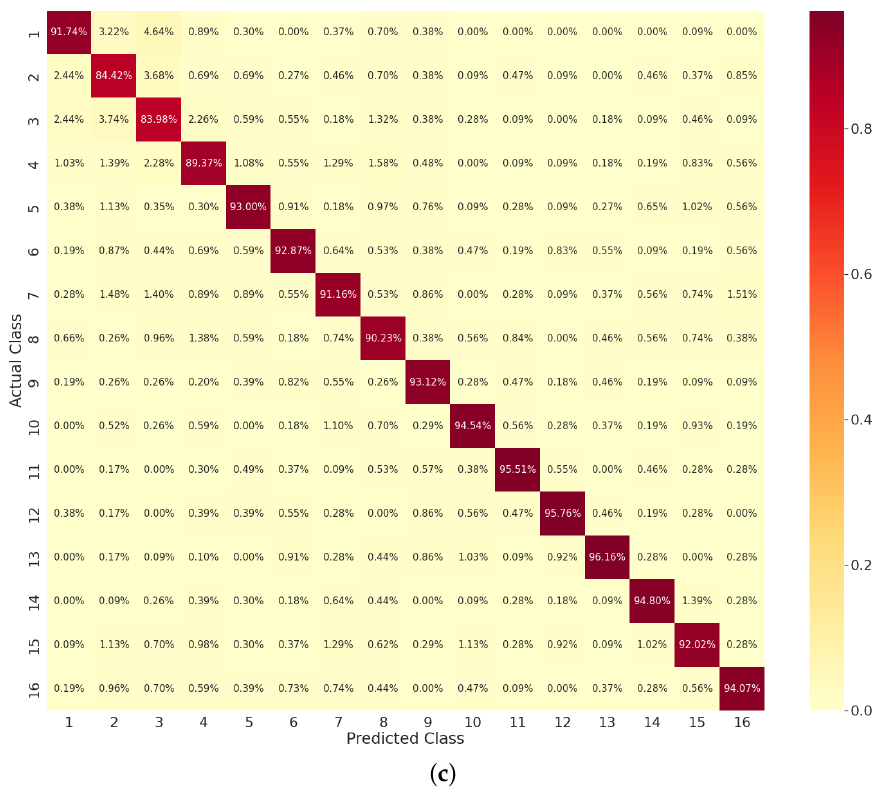
Figure 6. Confusion matrix report of sixteen distinct activity classes by trained model: ( a ) extra tree; ( b ) random forest; ( c ) decision